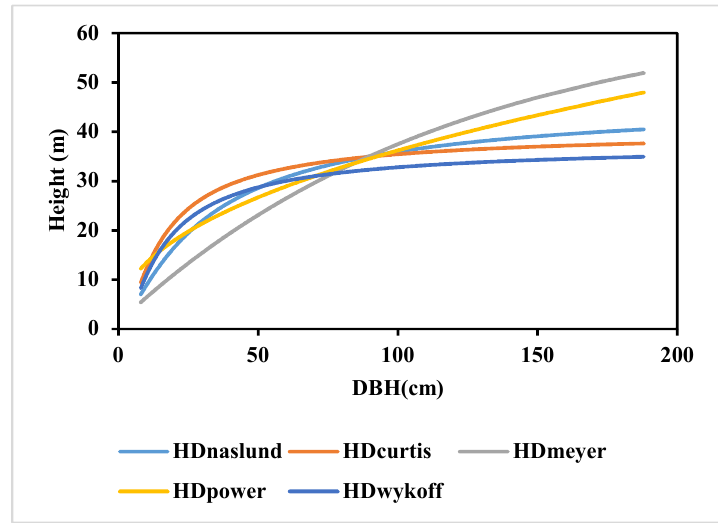
The best models based on R 2 and %RMSE are highlighted.